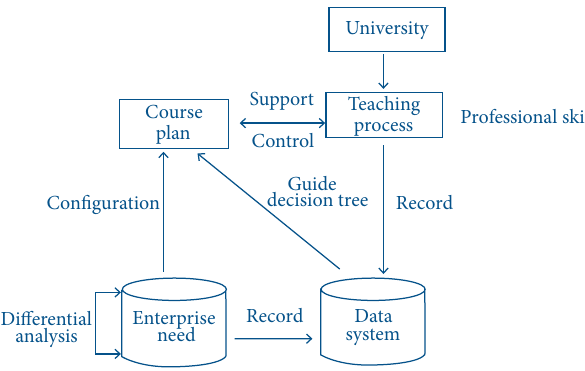
Figure 1: Framework of course plan recommendation.